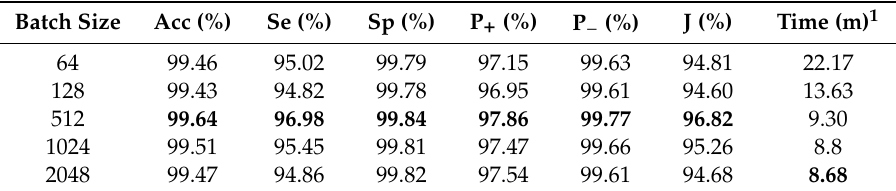
Table 7. Test the batch size’s e ff ect in detecting